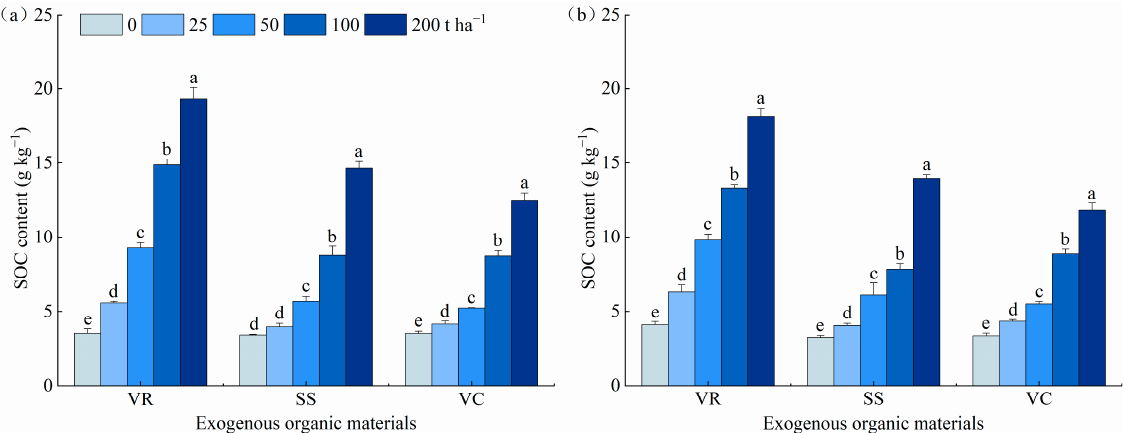
Figure 3. The accumulation of soil organic carbon in different organic material-treated saline-alkali soils: ( a , b ), soil organic carbon contents in 2020 and 2021, respectively; VR, vinegar residue; SS, sewage sludge; VC, vermicompost; OM, organic material; SOC, soil organic carbon. The vertical bars denote standard errors. Different small letters denote significant difference at p < 0.05. Table 2. Effects of different organic material application on nitrogen and phosphorus contents in saline-alkali soil.